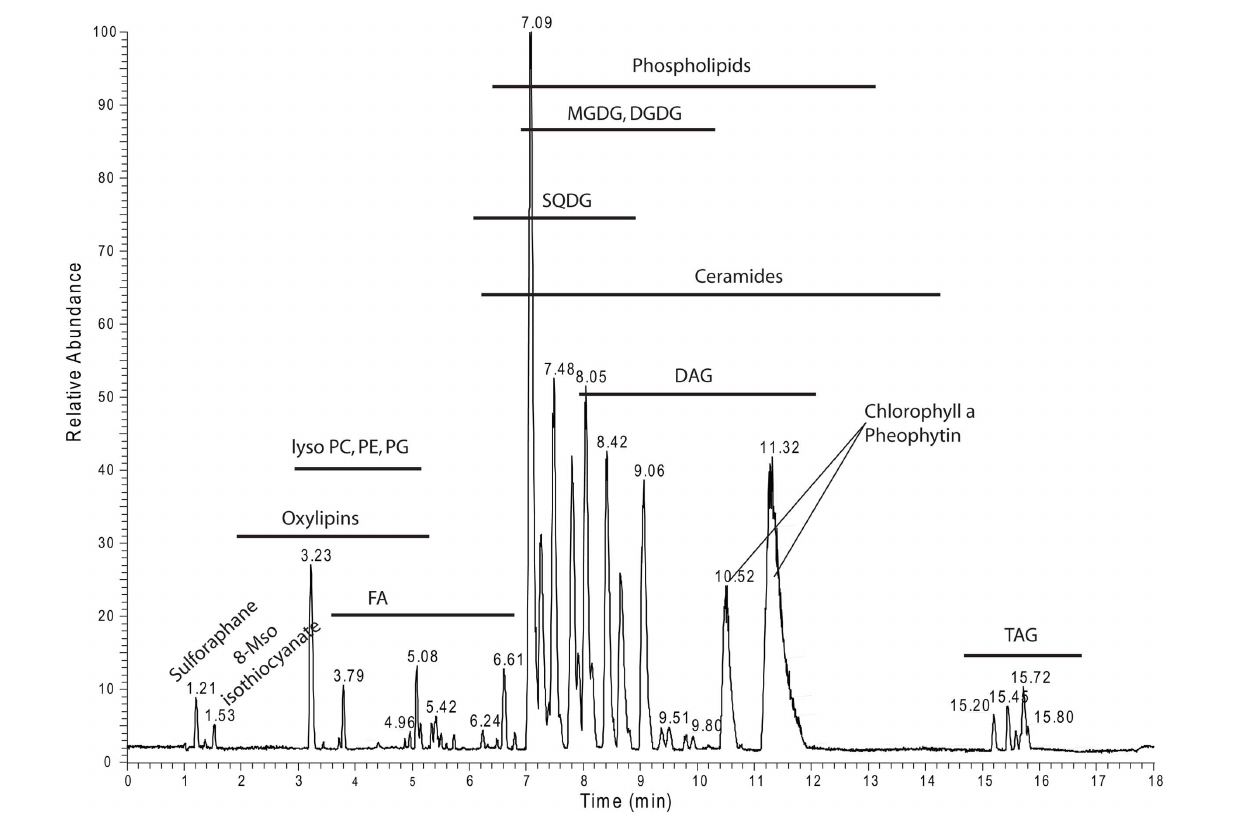
FIGURE 8 | Positive ion mode chromatogram from Figure 1A delineating the retention time areas of the different detected lipids fromTable S2 in Supplementary Material.